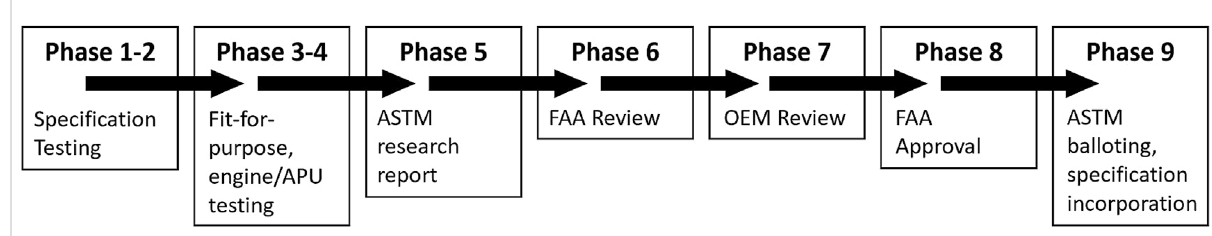
FIGURE 1 Summary of D7566 SAF approval process.